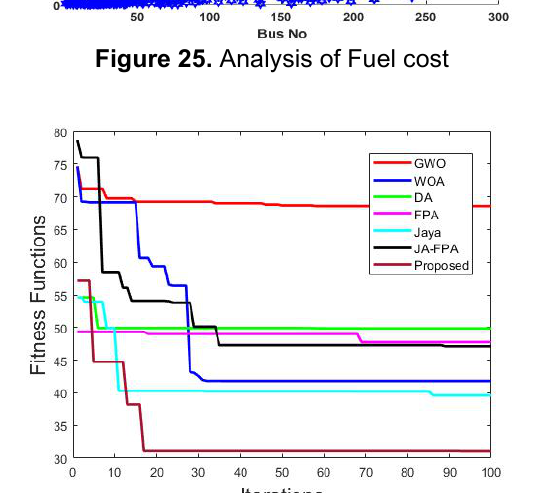
Figure 26. Comparative analysis of the fitness functions of the proposed system with existing systems. From the graphs plotted analysis, it is clear that from figure 19, the proposed system severity index attains